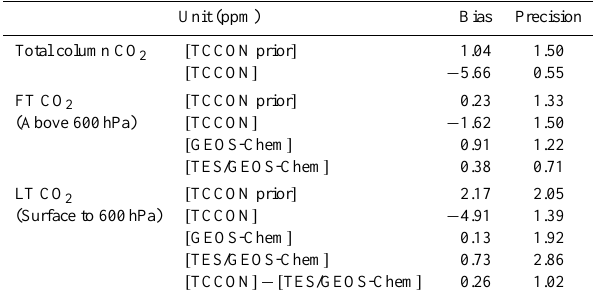
Table 3. Bias and precision